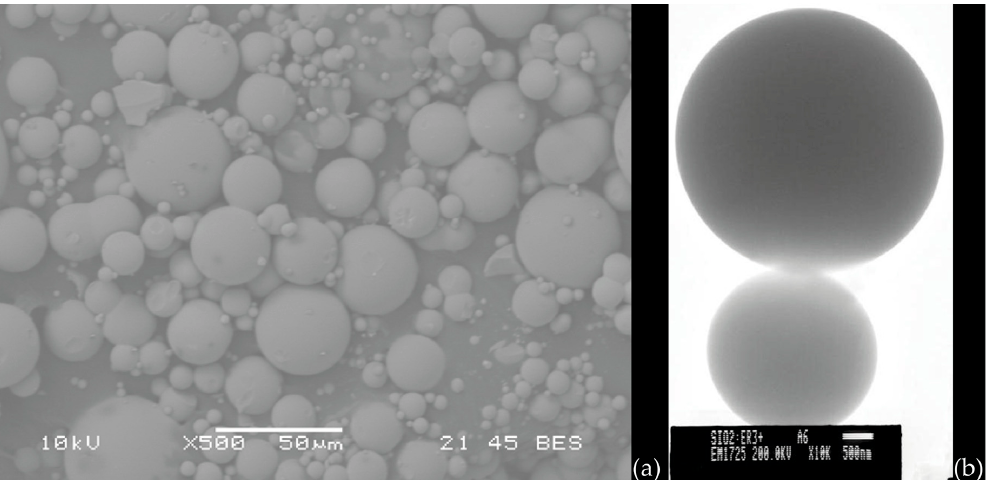
Figure 9. ( a ) SEM image of Er3+ silica spheres obtained by the acid catalyzed sol–gel route; ( b ) TEM image of two spheres demonstrating the high surface quality of the spheres. Reproduced from [82],